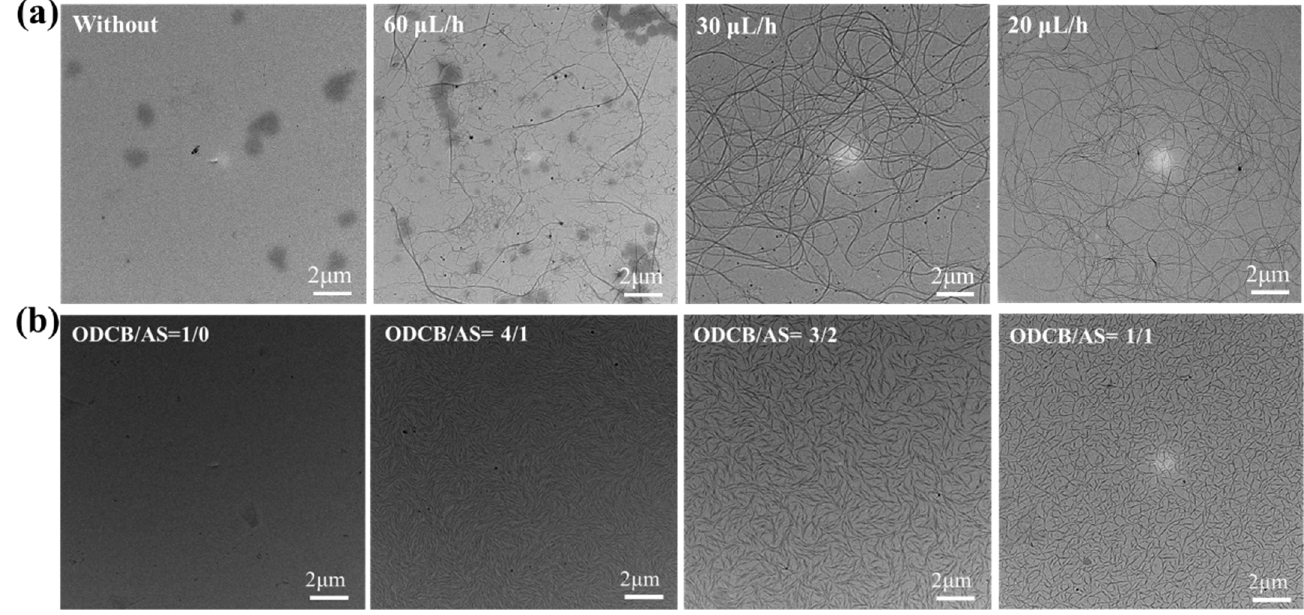
Figure 11. ( a ) TEM images of PDBT films dropcasted from slow evaporated solutions with different evaporation speeds, which were adapted from reference [112] with permission from Copyright 2017 Elsevier Ltd. ( b ) TEM images of PDPP films dropcasted from slow evaporated solutions with different cosolvents, which were adapted from reference [95] with permission from Copyright 2018 Wiley.